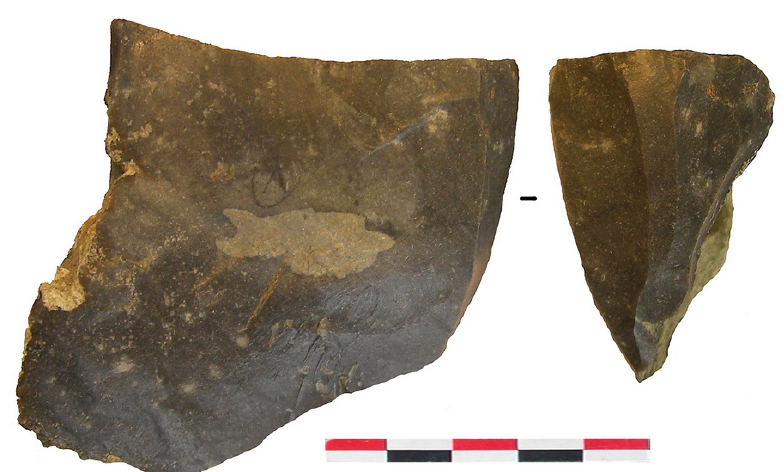
Figure 5. Oeudeghien (Belgique). Nucléus à lamelles sur tranche d’éclat (Crombé et al. 1992) (photo : P. Allard). (L’échelle est de 5 cm divisée en segments de 1 cm.) Figure 5. Oeudeghien (Belgium). Bladelet core on flake edge (Crombé et al. , 1992) ( photo: P. Allard). (Scale bar is 5 cm wide, divided into 1 cm sections.)